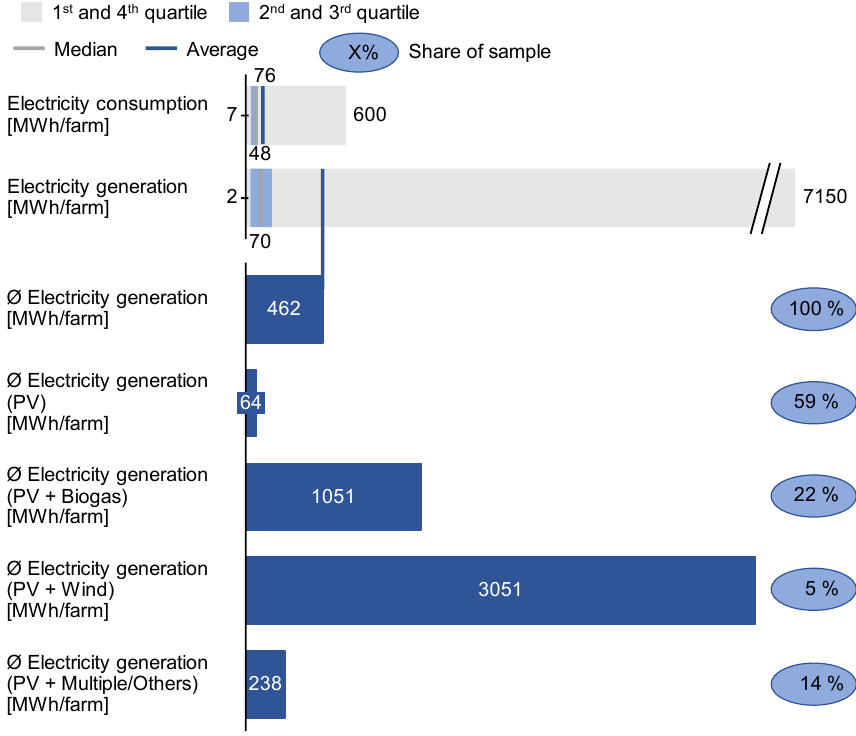
Figure 2. Electricity consumption and generation of the sample farms in 2021.